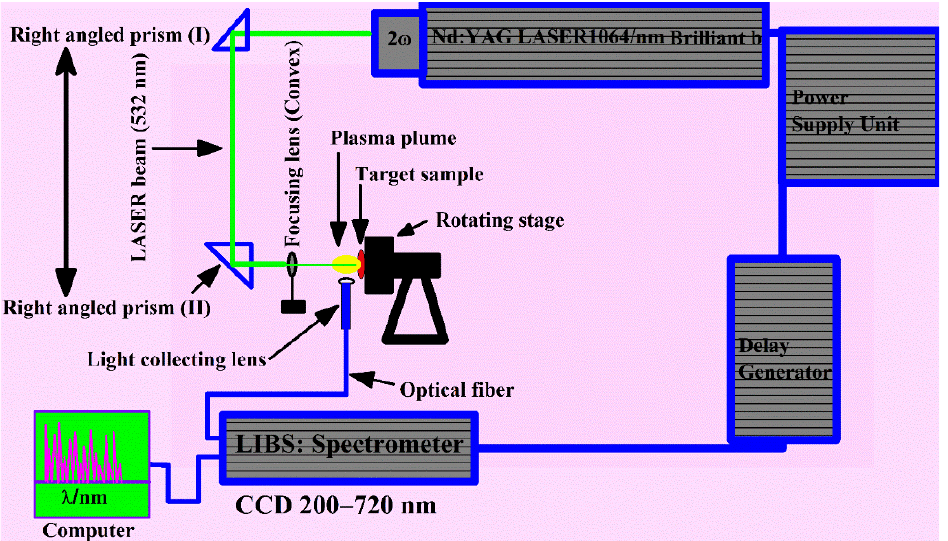
Figure 1. Schematics of LIBS setup utilized to investigate the laser-produced plasma emission of the plant biochar samples.